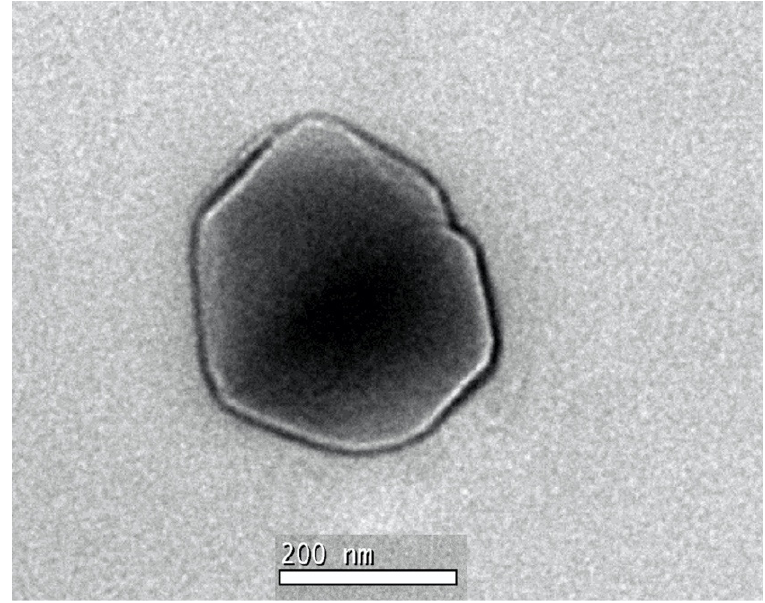
Figure 13. Transmission electron microscopy image of WPI-CS nanoparticles.